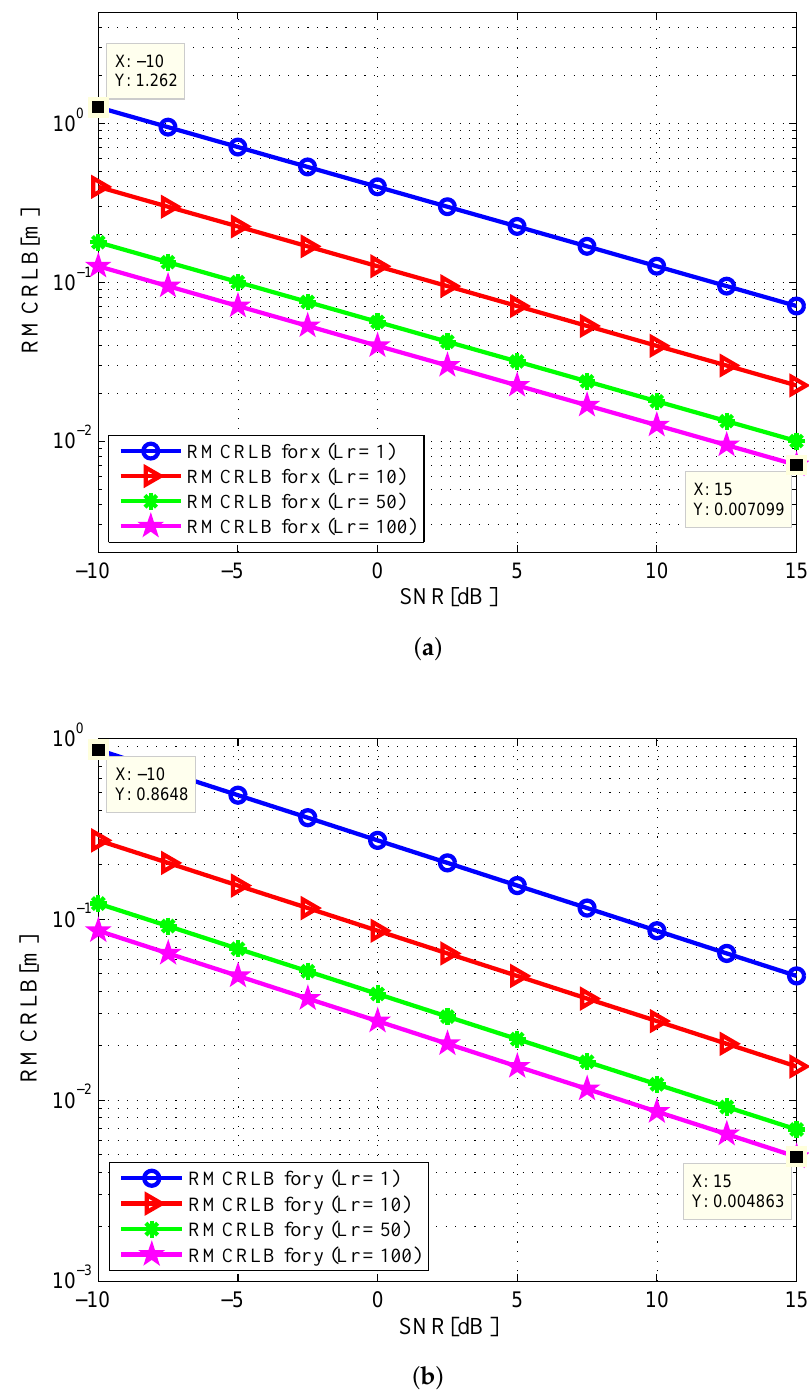
Figure 8. RMCRLB versus SNR in the target position dimensions with different L r when N = 1024 × 512 and T = 10 µ s: ( a ) x-position; ( b )